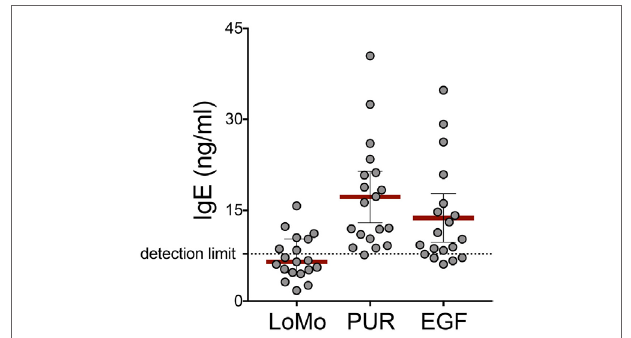
FigUre 4 | IgE reactivity against PUR extract, LoMo peptides, and epidermal growth factor (EGF). IgE from plasma of mouse allergic donors was measured by ELISA against coated LoMo peptides, urine high molecular extract (PUR) fraction, or rEGF. Concentration values for each condition were extrapolated from a calibration curve generated with recombinant IgE titrations read in the same plate. Values represent the average of duplicates, and each dot represents one donor. Detection limit (7.8 ng/ml) represents the sensitivity of the